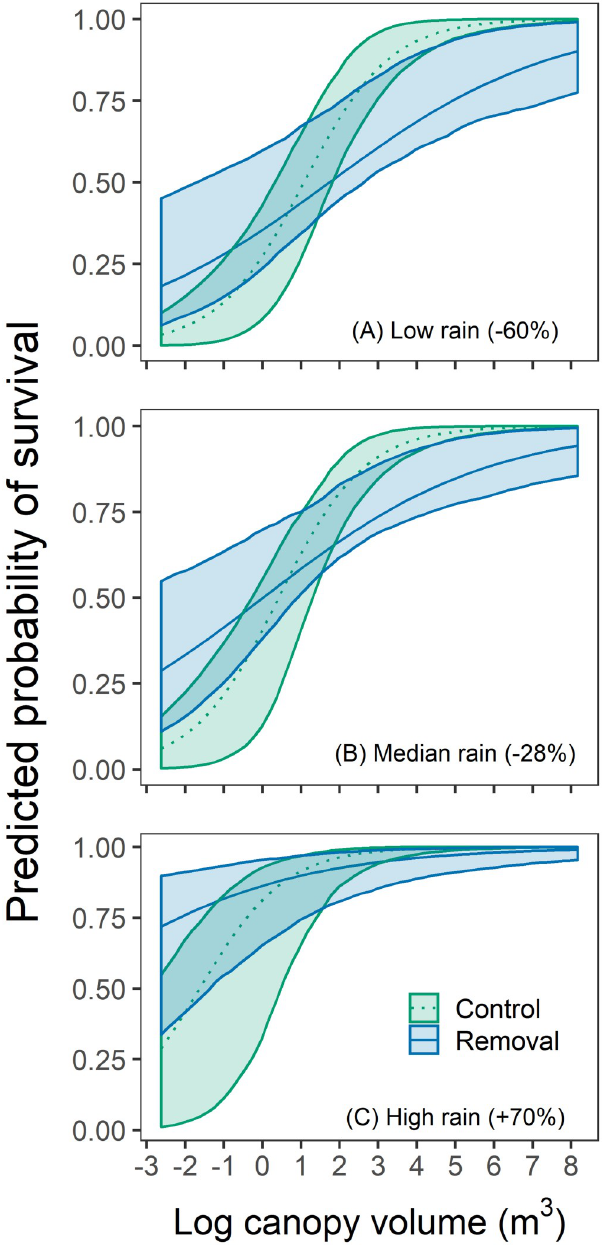
Fig 3. Effects of non-native plant removal on the probability of survival in adults of different sizes. The three panels show predictions for spring rainfall at (A) the study minimum (60% below the 1999–2020 average), (B) the study median (28% below average), and (C) the study maximum (70% above average). Center lines for each group show best-fit predictions, and the filled areas 95% confidence bounds based on bootstrap replicates.